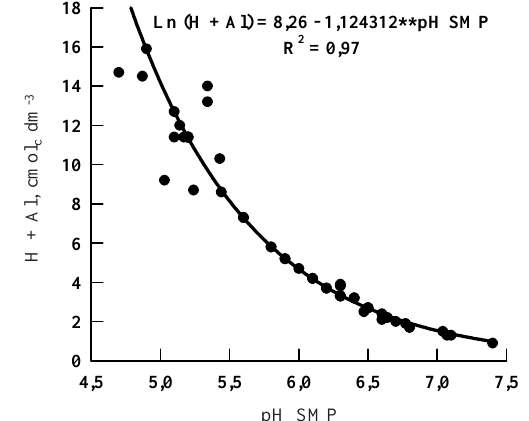
pH SMP Figura 1. Relação entre acidez potencial (H + Al) extraídos com acetato de cálcio e pH SMP para solos da Região do Vale do Jequitinhonha. (** significativo a 1% pelo teste t)